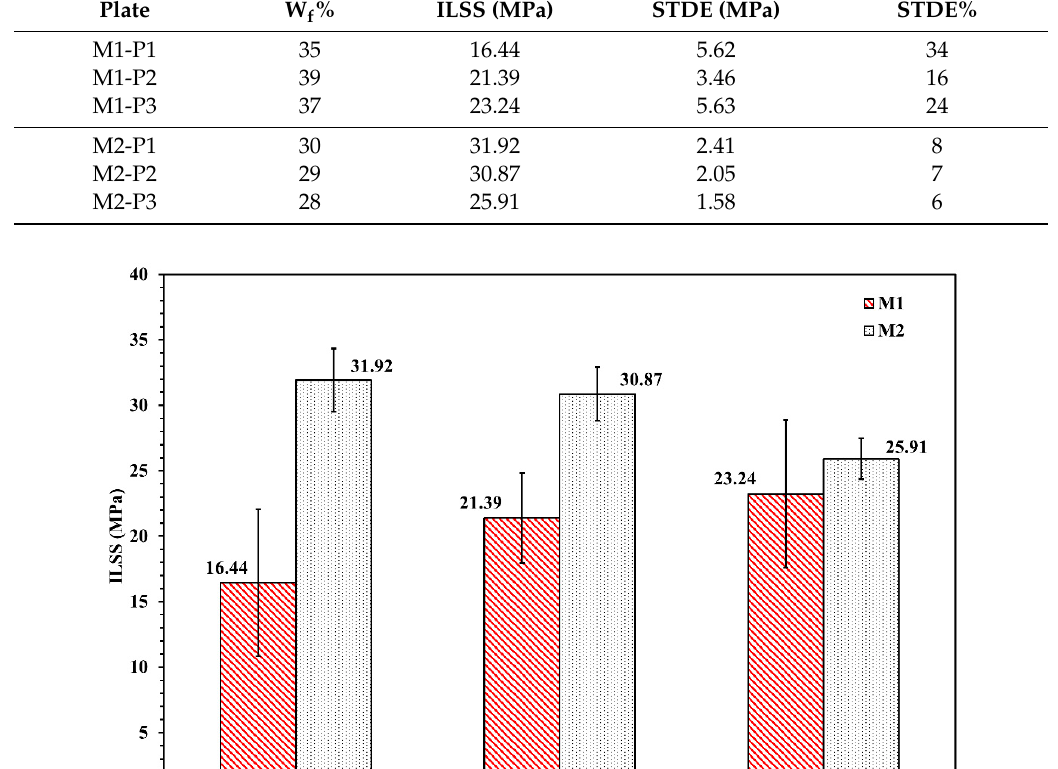
Table 7. Normalized average ILSS values of each set for a unified fiber weight fraction of 33% .